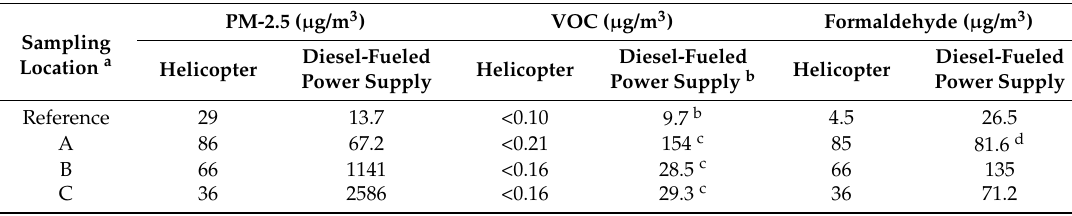
Table 2. Source characterization of source emissions.